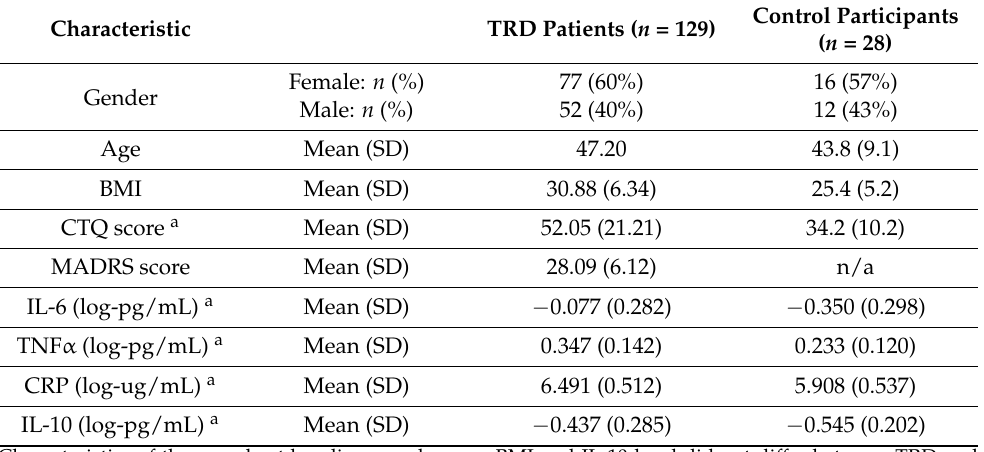
Table 1. Baseline